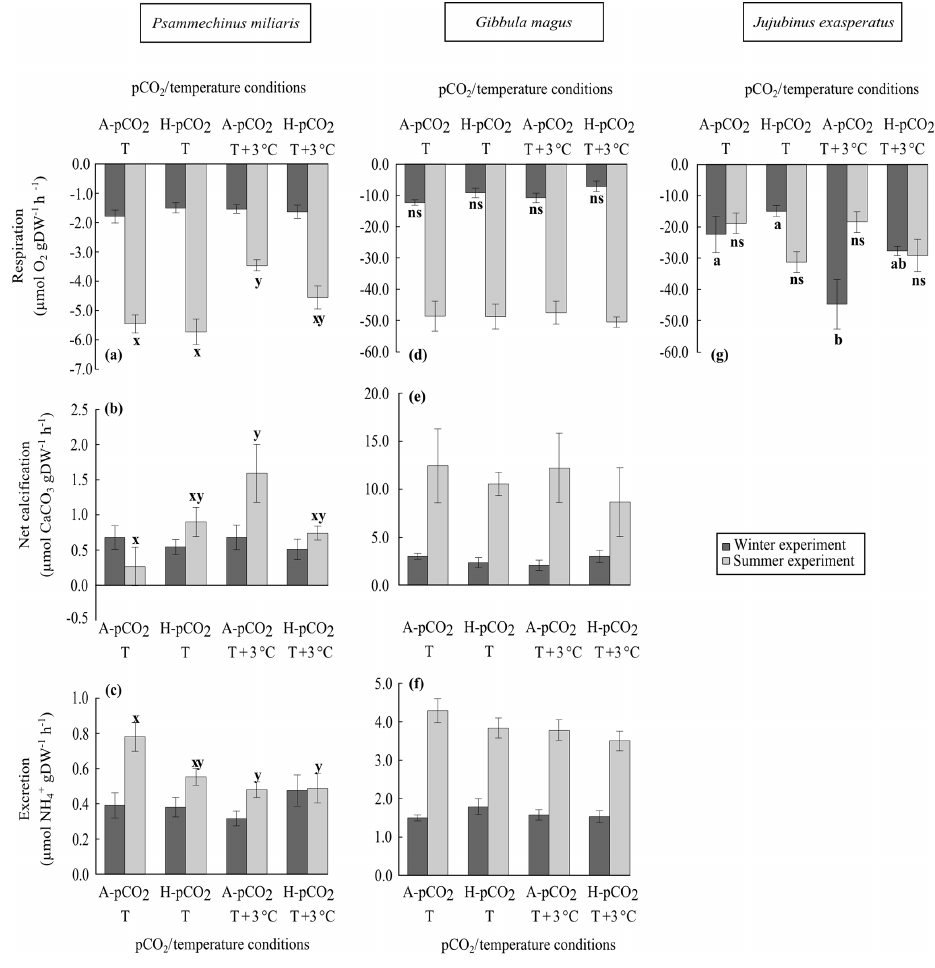
Figure 1. Respiration, net calcification, and excretion rates (mean ± SE, n = 5) of the grazers P. miliaris (a–c) and G. magus (d–f) and respiration of J. exasperatus (g) in the different p CO 2 (A- p CO 2 is ambient p CO 2 ; H- p CO 2 is high- p CO 2 ) and temperature ( T is ambient temperature; T + 3 ◦ C is high temperature) conditions. The species were maintained in assemblages for 3 months in winter (dark gray) and summer conditions (light gray). Different letters show significant differences (Tukey HSD test) between the four treatments in the winter (letters a and b) and summer (letters x and y). ns is not significant. Tukey tests were performed when a significant effect of temperature or p CO 2 was detected using two-way